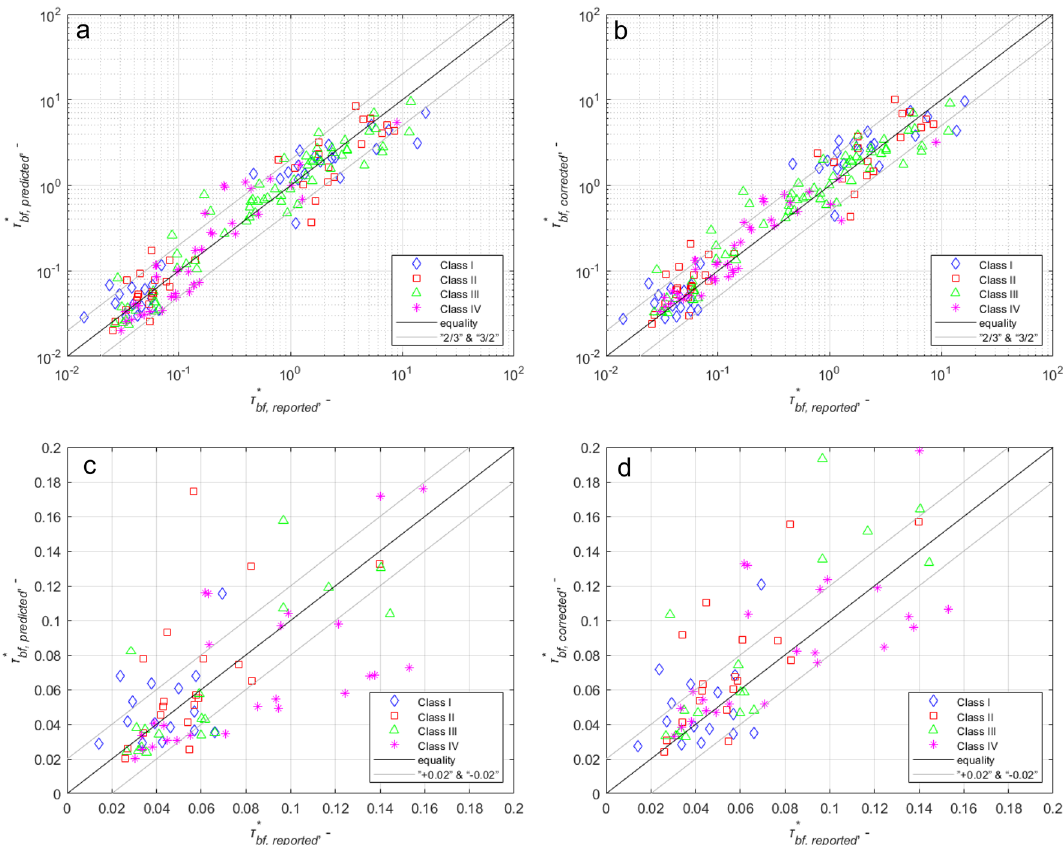
Figure 4. Panels ( a , c ) show points predicted by Li et al.’s estimation versus the reported bankfull Shields number τ ∗ bf . ( b , d ) show predictions from Eq. (2) versus reported bankfull Shields number τ ∗ bf . The colors and symbols refer to the riparian vegetation density, as shown in the legend. The two figures on the left show the prediction by Li et al., and the figures on the right show the results of the improved relationship (Eq. 2). The lower two figures (c and d) show the range 0–0.2 of the vertical axis. This range more clearly illustrates the improvement. The solid black line shows equality, and the gray lines the 20% margin of